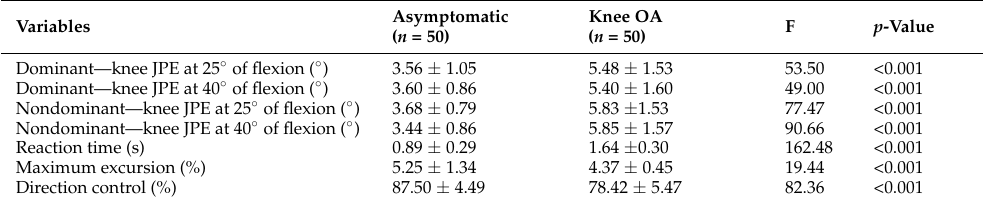
Table 2. Comparison of knee joint position sense and limits of stability tests between knee OA and asymptomatic groups.